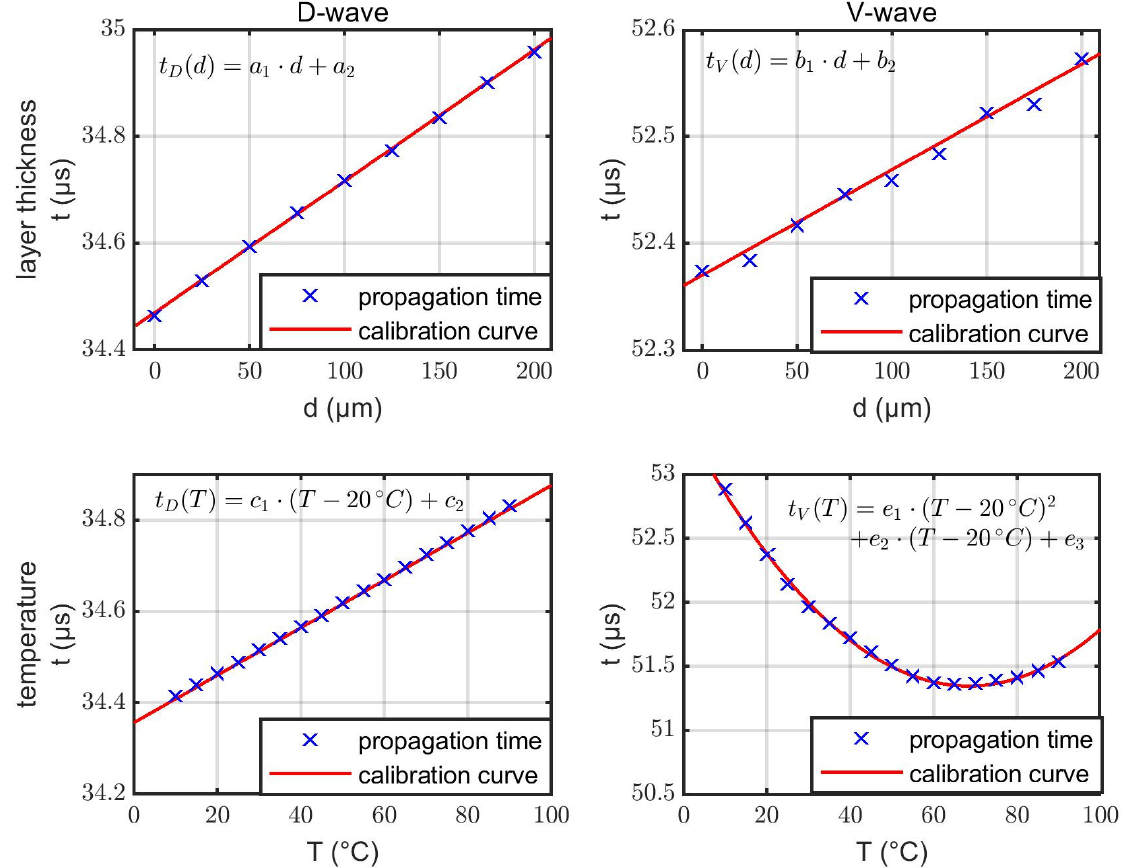
Figure 6. Evaluated propagation times t D and t V (blue crosses) related to changes in layer thickness d and temperature T without mutual interdependencies. In addition to the simulation results, fitted calibration curves (red lines) including their mathematical representations are shown.